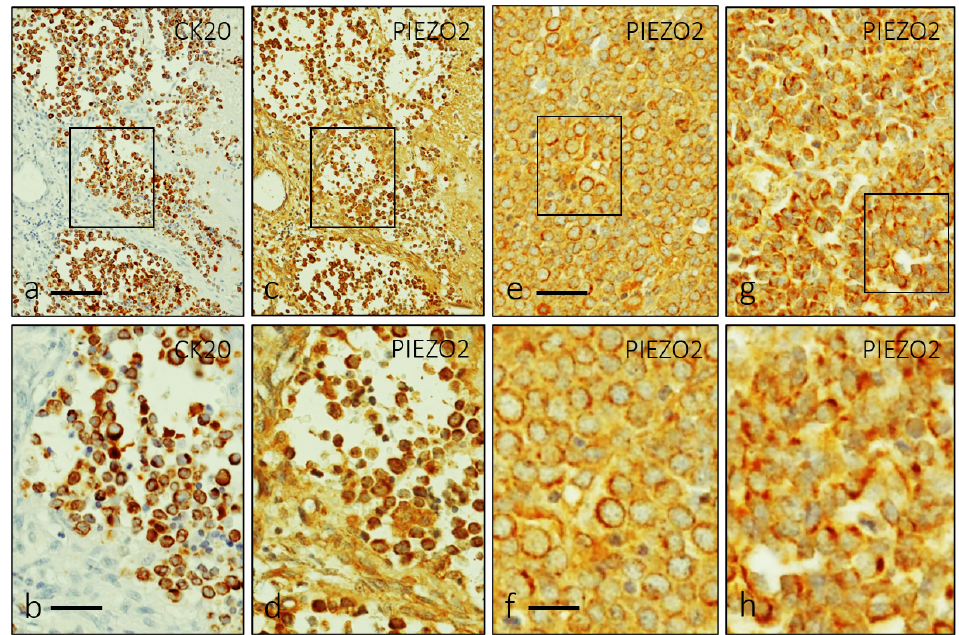
Figure 2. Single immunohistochemistry for CK20 ( a , b ) and PIEZO2 ( c – h ) in approximate serial sections showing a perinuclear pattern of distribution identical for both proteins. A detailed examination reveals two patterns of PIEZO2 immunostaining: cytoplasmic with perinuclear halo ( e , f ) and dot-like ( g , h ). Scale bars 100 µm ( a , c , e , g ), 50 µm ( b , d ), 20 µm ( f , h ).